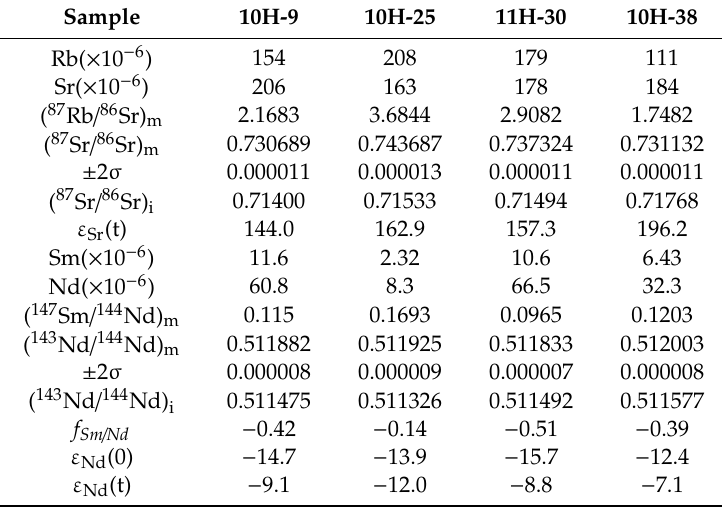
Table 4. Sr, Nd, and Pb isotopic compositions of biotite granite samples investigated as part of this study.